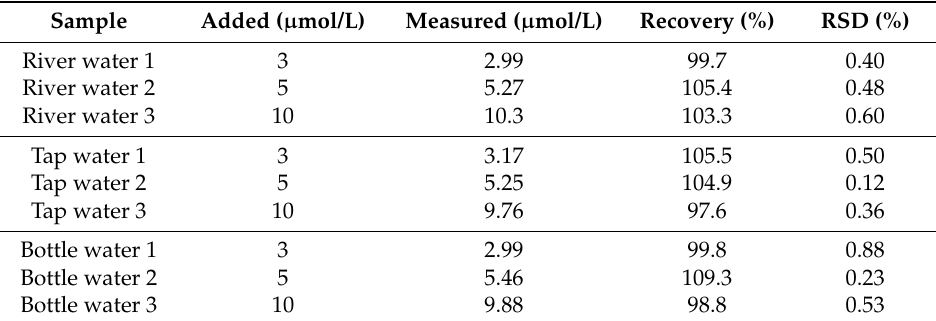
Table 2. Determinations of Al 3+ in real samples ( n = 3).